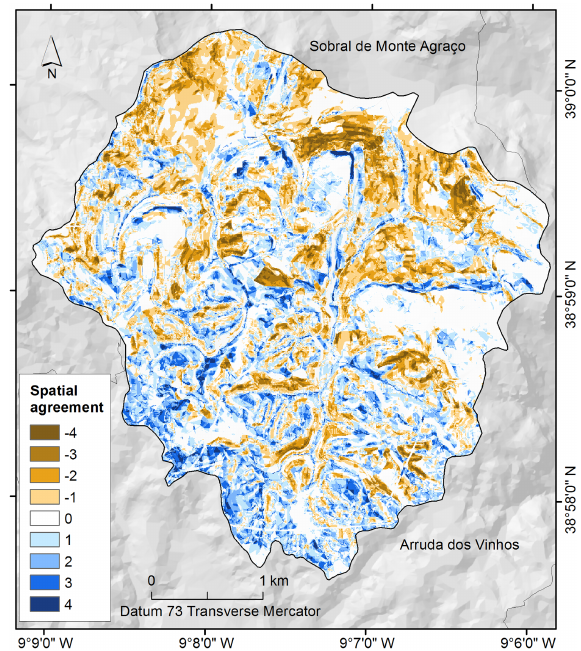
Figure 9. Spatial agreement between IV and IS shallow slide sus- ceptibility maps. A value of 0 means full agreement; 4 and − 4 mean maximum disagreement.